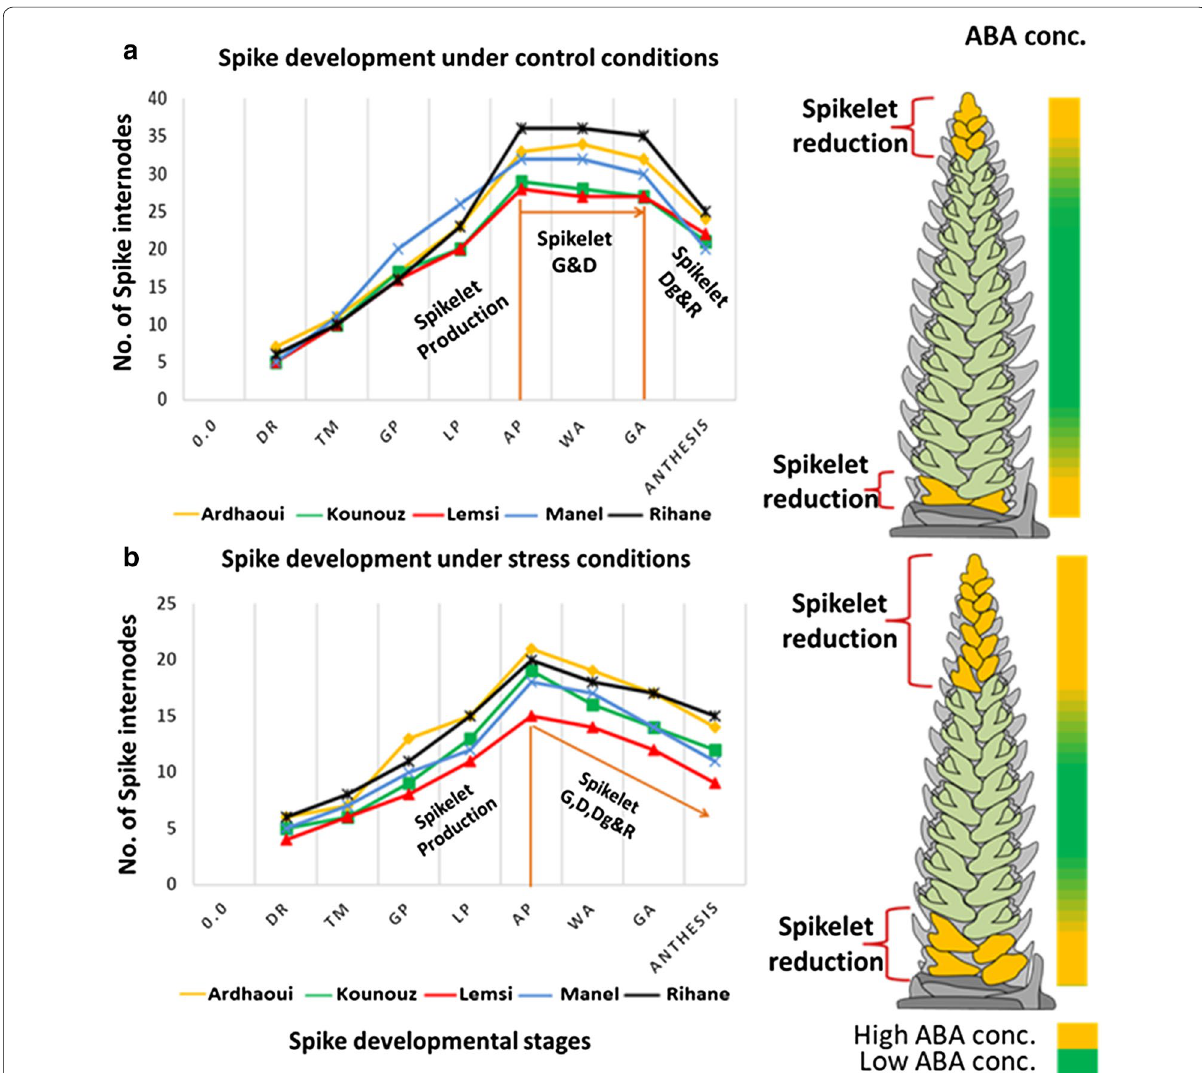
Fig. 7 Barley spikelet production, growth, development, degradation and reduction and ABA concentration in the immature spike in the five tested barley genotypes under control ( a ) and salinity stress ( b ) conditions. DR double ridge, TM triple mound, GP glume primordia, LP lemma primordium, AP awn primordium, WA white anther, GA green anther, G growth, D development, Dg degradation, R